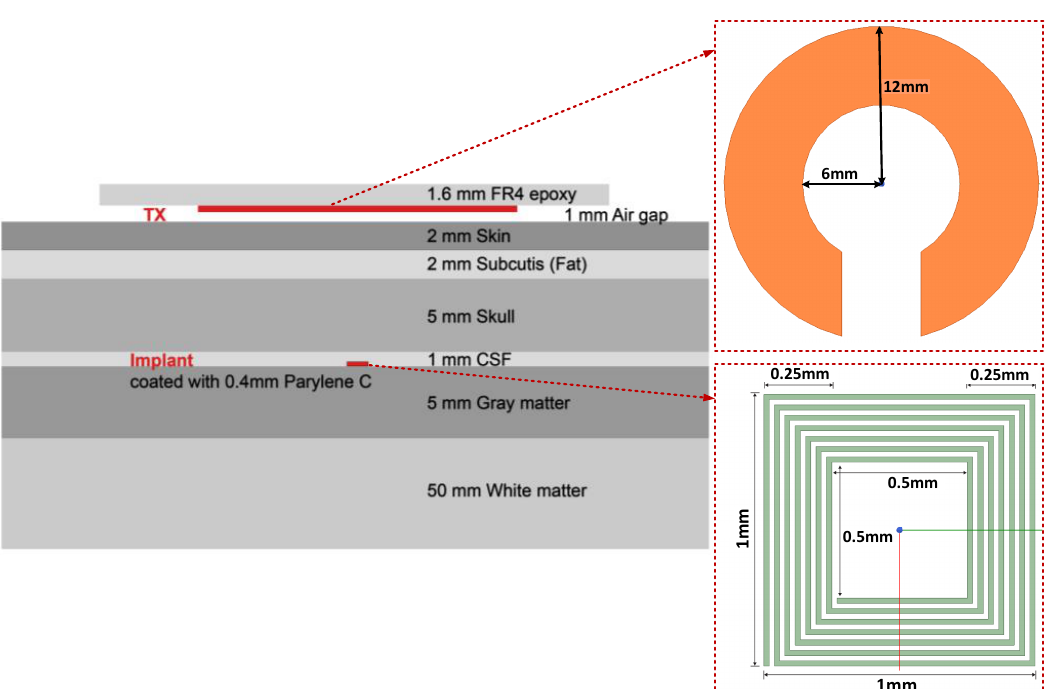
Figure 3. Cross-sectional configuration of the implemented finite element method (FEM) model in High-Frequency Structure Simulator (HFSS). The 1 × 1 mm 2 -sized seven-turn-coil implant is placed at 9.7-mm depth of the brain. The one-tern circular transmitter (TX) is placed above the